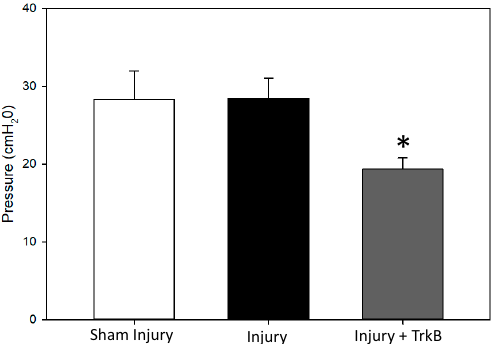
Figure 2. Leak-point pressure results. Leak-point pressure 6 weeks after sham injury treated with saline (Sham Injury); pudendal nerve crush (PNC) and vaginal distension (VD) injury treated with saline (Injury); or PNC + VD injury treated with tyrosine kinase B (TrkB) fusion chimera (Injury + TrkB). Each bar represents mean ± standard error of the data from 11–14 animals. There were 4–6 LPP tests per animal. A Welsh one-way analysis of variance (ANOVA) with a Dunnett’s T3 post hoc test was used to determine statistically significant differences ( p < 0.05) compared to the Injury group. * indicates a statistically significant difference compared to the Injury group.